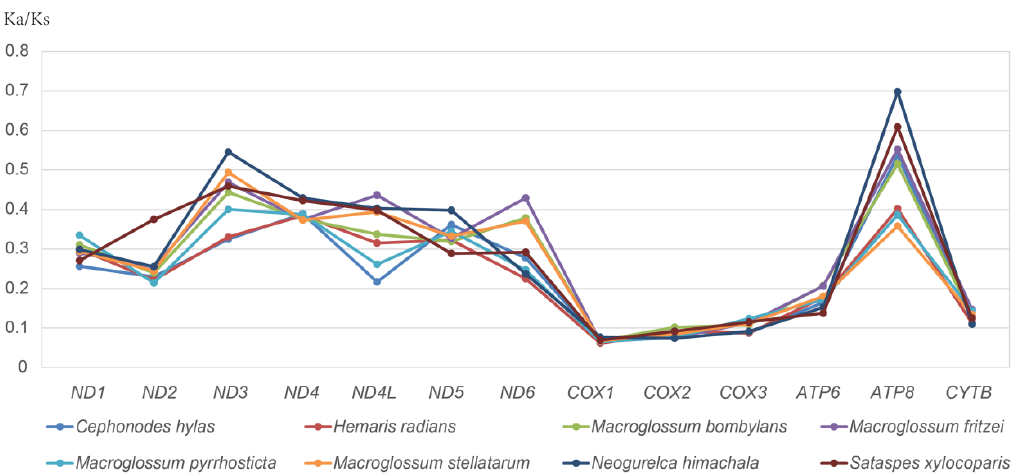
Figure 3. Evolutionary rates of 13 protein-coding genes of eight diurnal hawkmoths, comprising three cytochrome coxidase subunits ( cox 1-3 ), cytochrome b ( cob ), two ATPase subunits ( atp6 and atp8 ), and seven nicotinamide adenine dehydrogenase subunits (nad1-6 and nad4L ). The numbers of nonsynonymous substitutions per nonsynonymous site (Ka), the number of substitutions per synonymous site (Ks), and the ratio of Ka/Ks for every genome are given, using Neoris haraldi as the reference sequence.